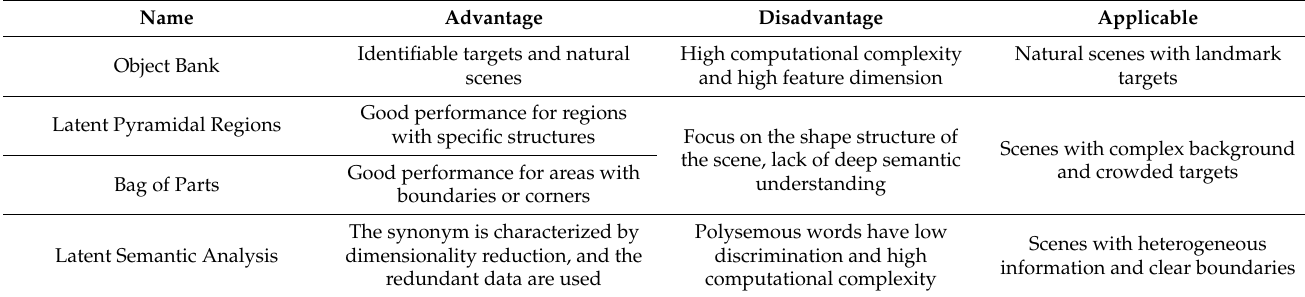
Table 3. Comparison of main methods in target